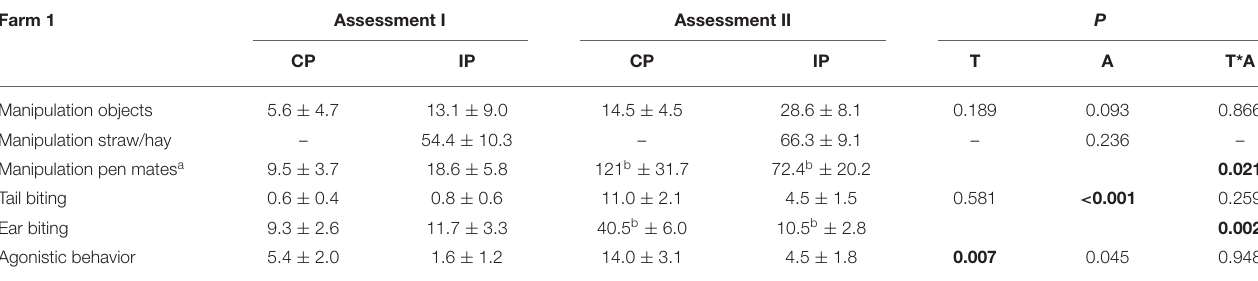
TABLE 4 | Frequency of behaviors (number of events/100 animals*10min; LS-means ± standard error of means) for pigs in IP (improved pens) and CP (control pens) during assessments I (baseline) and II (middle of the fattening period) on Farm 1. Farm 1